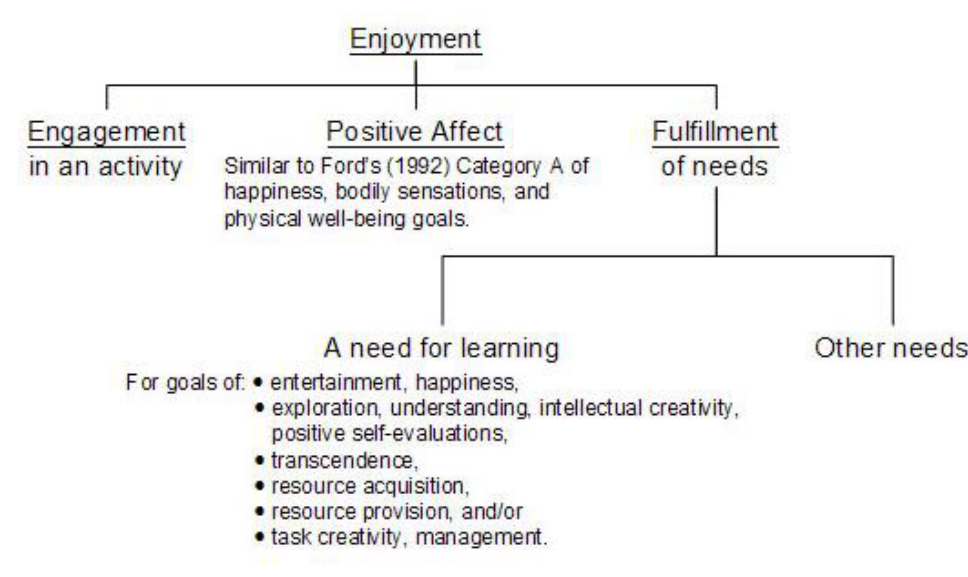
Figure 1. Enjoyment Arising from